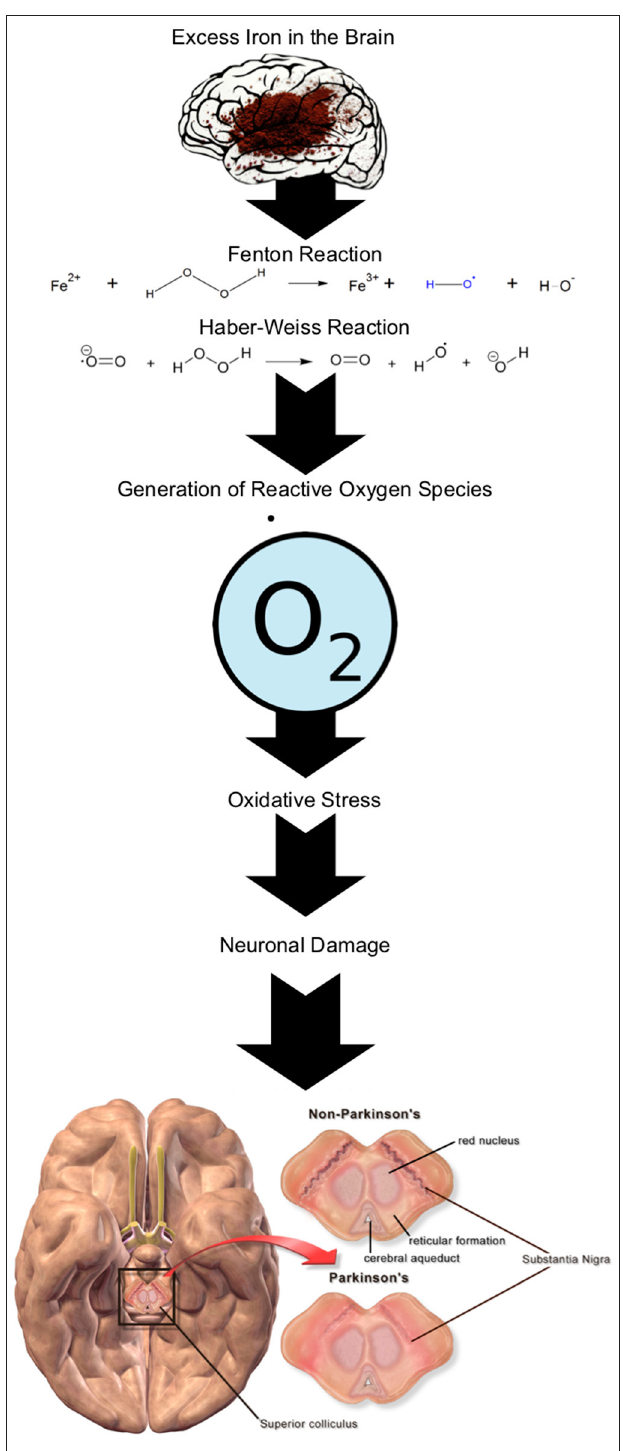
FIGURE 1 | Fenton-Haber-Weiss reaction in the presence of Fe in the brain generating reactive oxygen species leading to neuronal damage (O •− 2 = superoxide anion